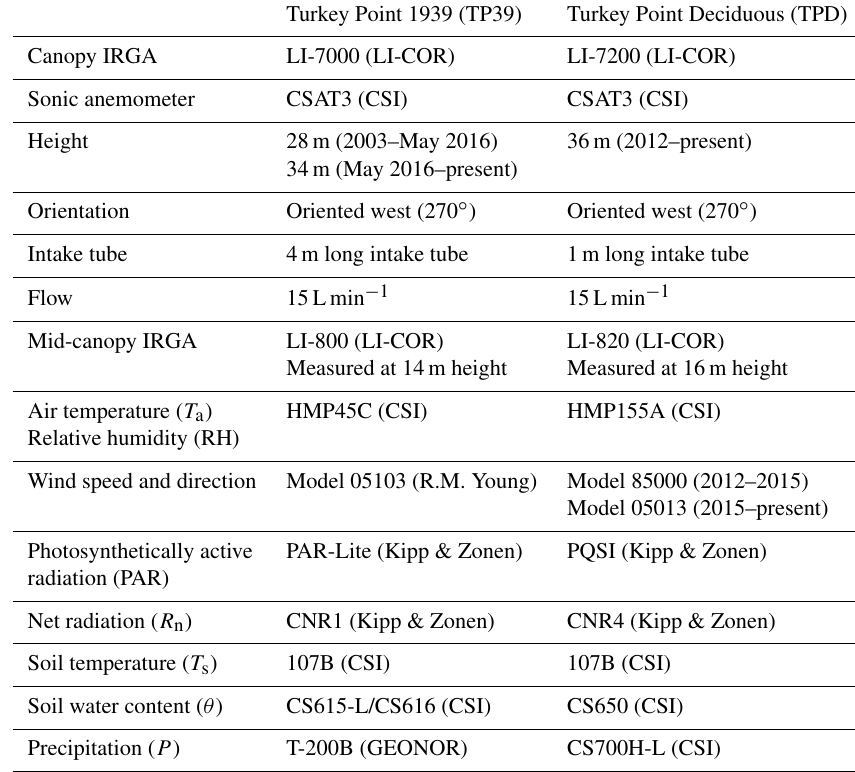
Table A1. Descriptions of the eddy covariance (EC) instrumentation and meteorological sensors used at both sites during the period of measurements. Note: IRGA = infrared gas